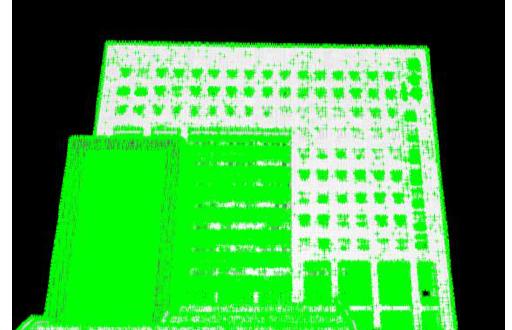
Figure 11. The point cloud with RGB color